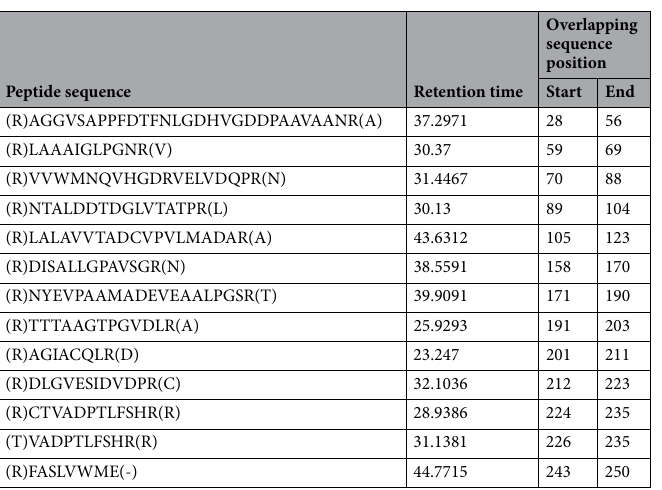
Table 2. Peptides identified from recombinant Mycobacterium tuberculosis MRA2164 protein.